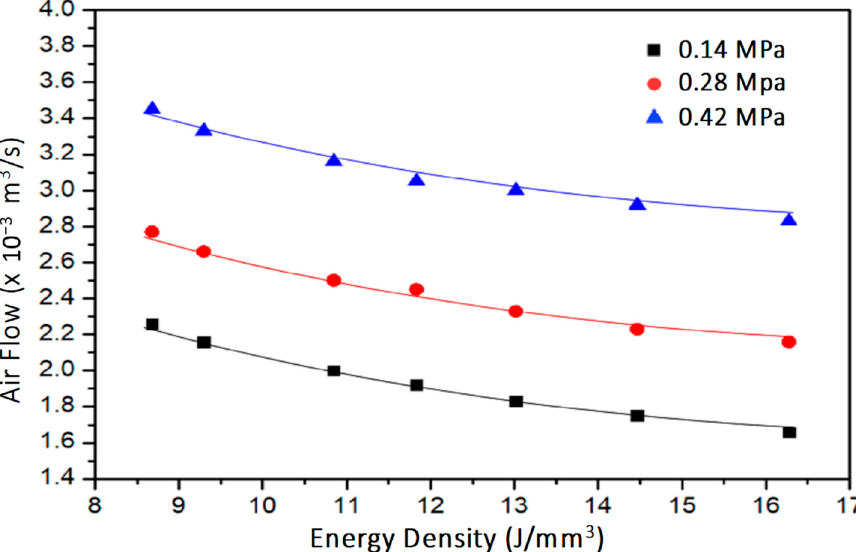
Figure 9. Change of air flow rate across the 4 mm cellular coupons made by different energy densities and tested at three inlet pressures.